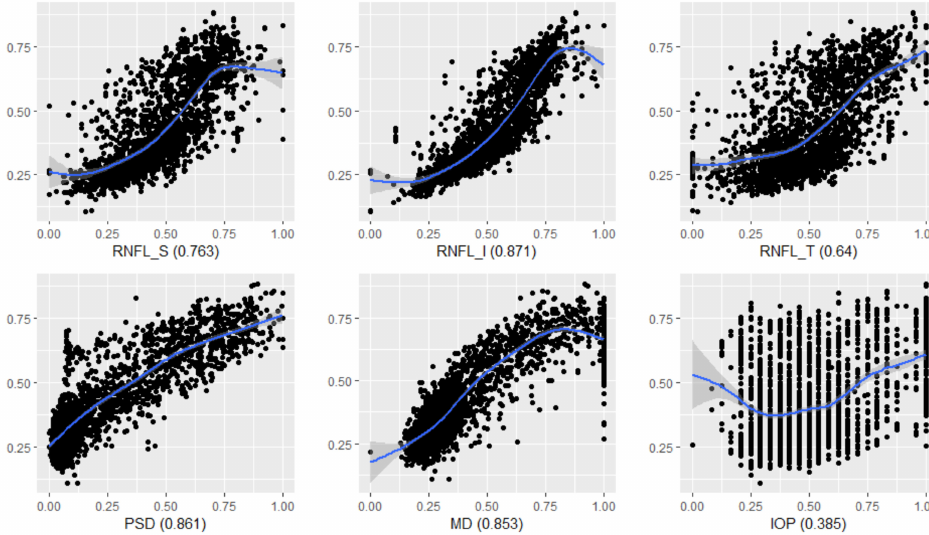
Figure 7. Scatterplots for the six features and I-GRI